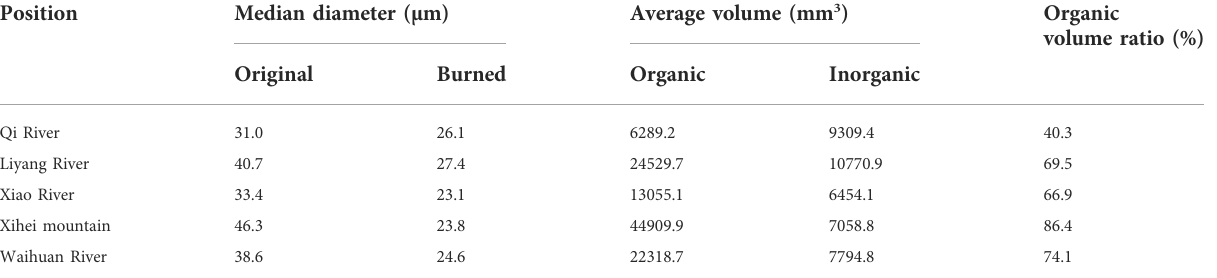
TABLE 2 Analysis of organic matter in siltation particles.